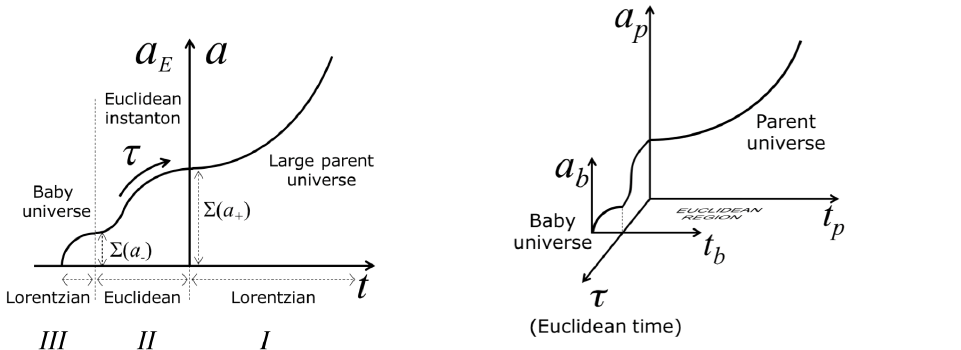
Figure 11. The creation of a large parent universe from a baby